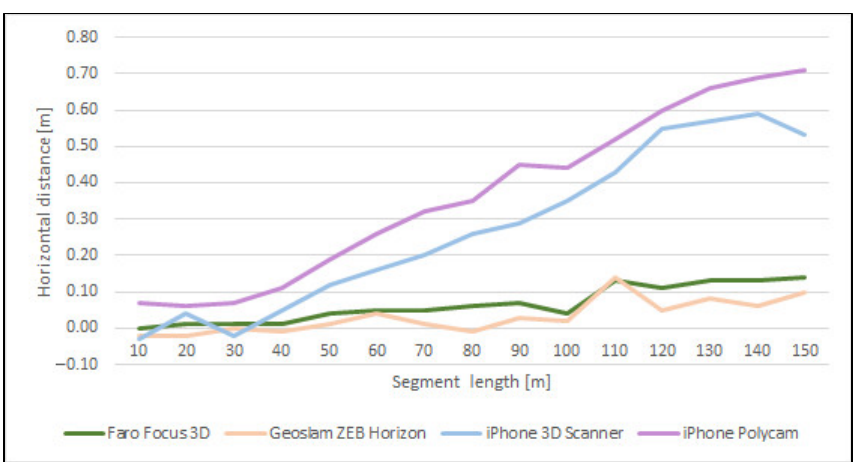
Figure 5. Comparison of lengths in the direction of the route (example from right side of the section